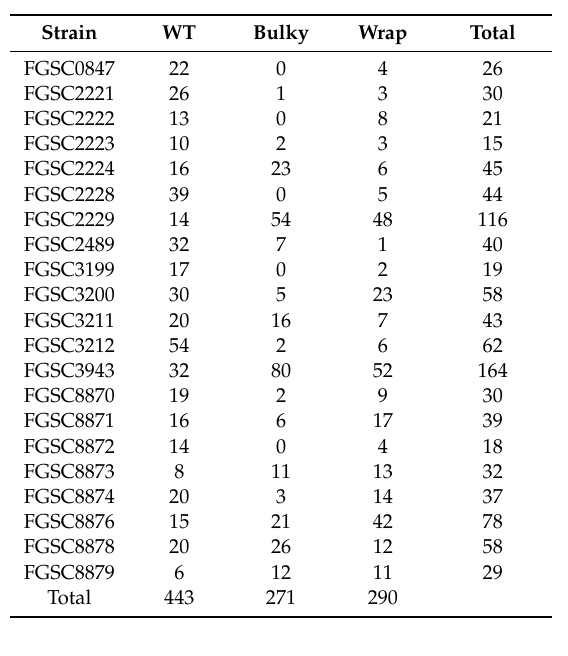
Table 1. Classifications of conidiophores belonging to each wild isolate (chi-squared test for